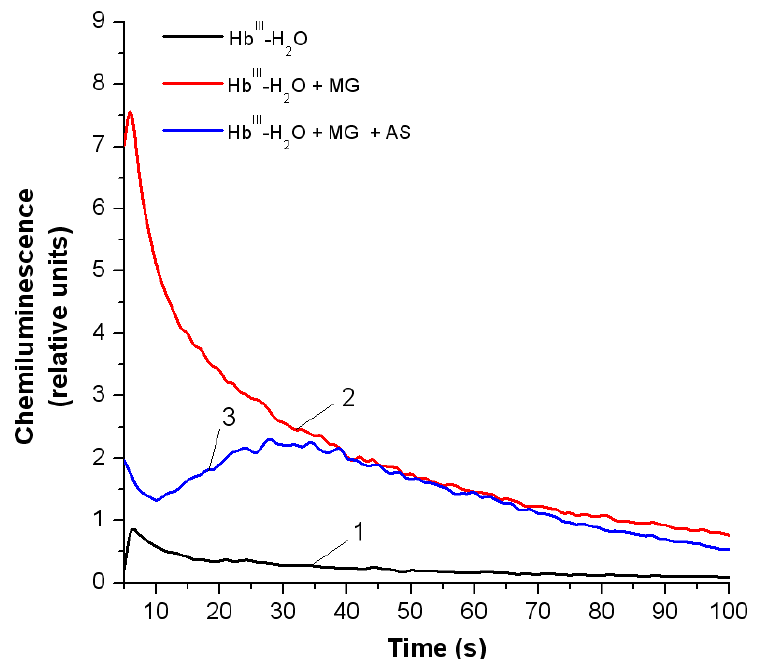
Figure 7. Effect of Angeli’s salt on the formation of free radical products in metHb-H 2 O reaction with MG, measured with luminol-dependent chemiluminescence. Control variant (without additives), black curve (1), with MG, red curve (2), with MG (13.5 mM) combined with Angeli’s salt (8 mM), blue curve (3). Reaction mixture as in Figure 2.